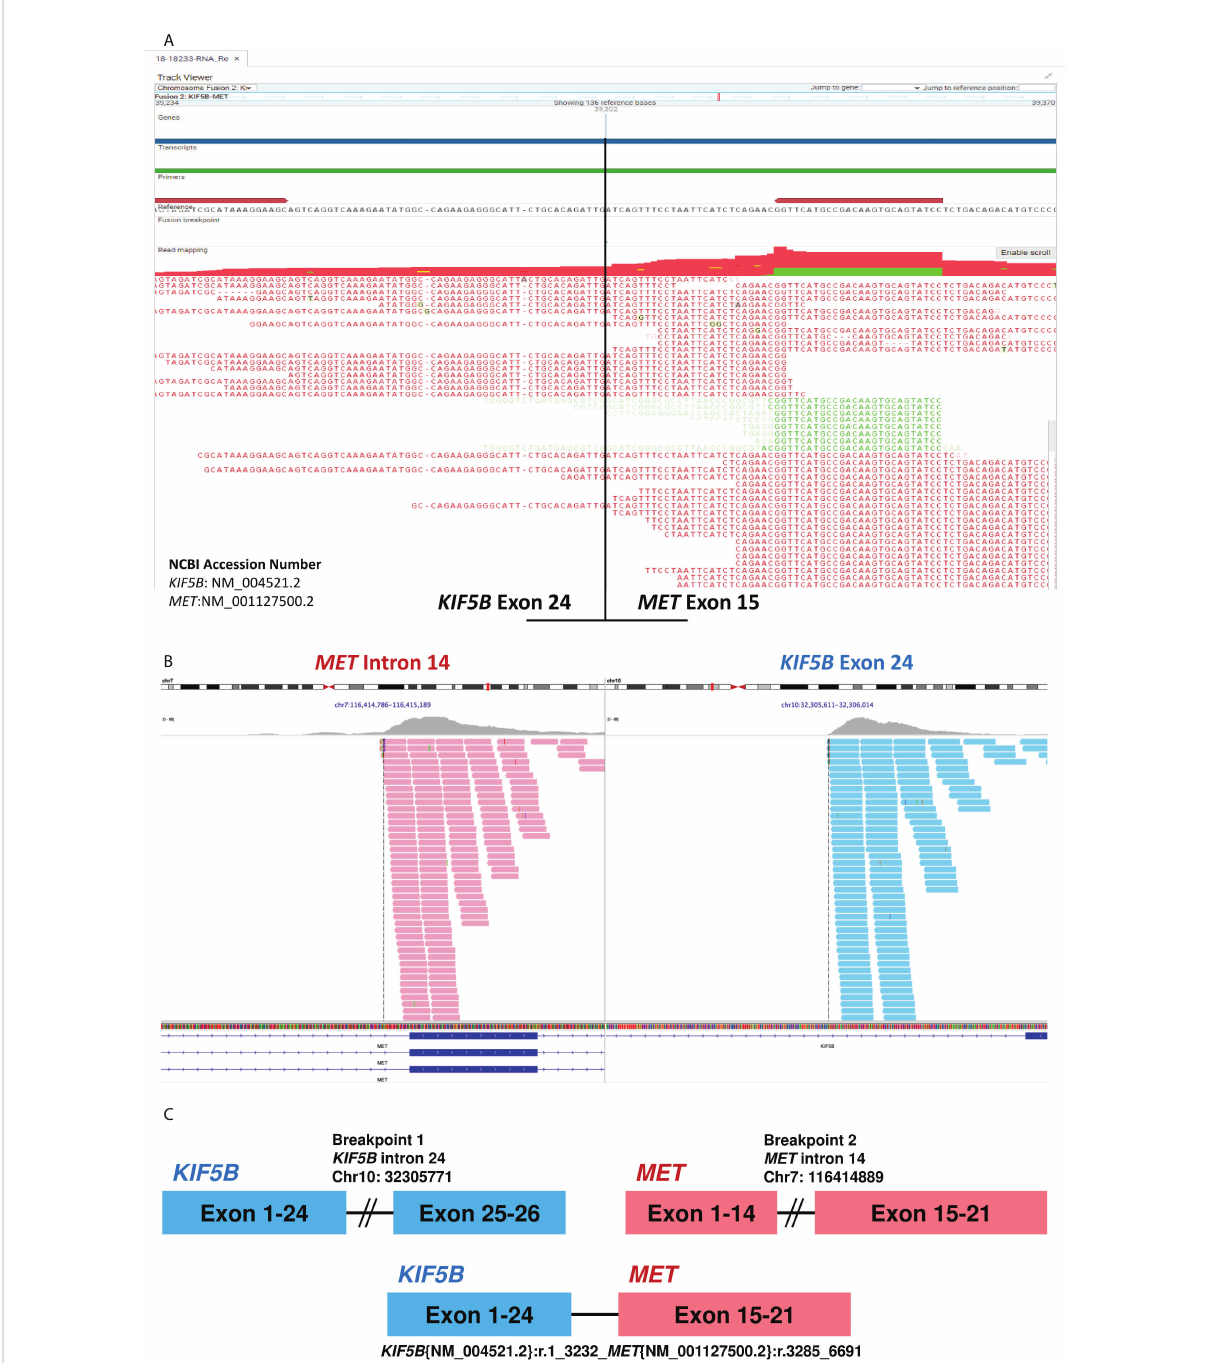
FIGURE 1 Next-generation sequencing of tissue before and after Telisotuzumab Vedotin. (A) The RNA-based NGS by QIAact Lung All-in-One assay revealed a KIF5B-MET (K24;M15) fusion. (B) The DNA-based NGS by FoundationOne ® CDx after Telisotuzumab Vedotin still revealed KIF5B-MET fusion. The data was provided by the Department of Research and Development, Foundation Medicine Inc. (C) The diagram of KIF5B-MET fusion. NGS, next-generation